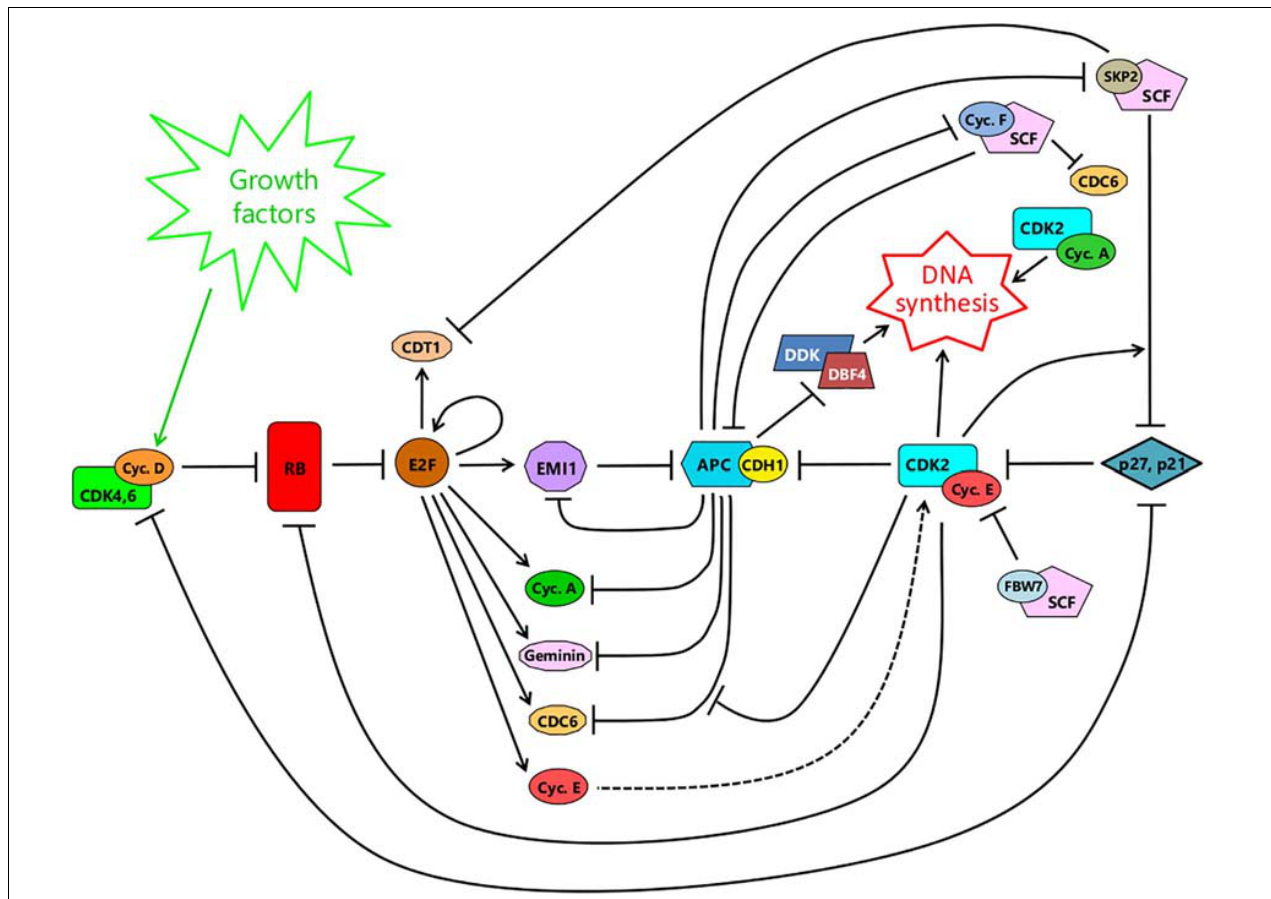
FIGURE 4 | A schematic integrating the RB-E2F switch (left) with the APC/C CDH1 switch (center-right) . For details, see